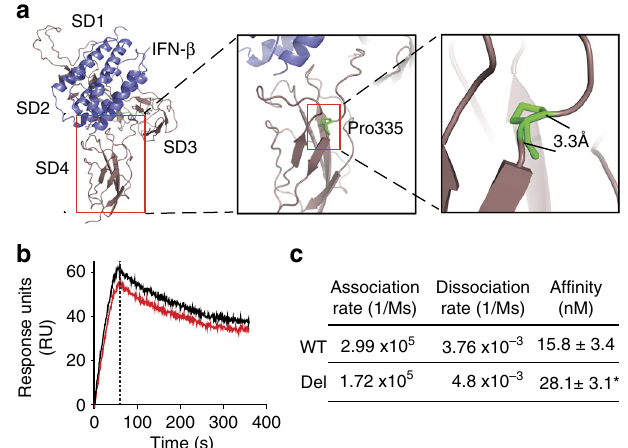
Fig. 6 TCC deletion in IFNAR1 decreases the af fi nity of IFN- β for IFNAR1. a Model of human IFNAR1 (brown; SD1 – 4) in complex with IFN- β (blue) and the location of Pro335 deletion. The model was generated using the crystal structure of the homologous mouse IFNAR1/IFN- β complex (PDB code 3WCY 53 ), illustrating overall receptor structure and position of the identi fi ed deleted residue (P335; green) in the inter-domain hinge between SD3 and SD4 of human IFNAR1. b , c The effect of TCC deletion on the IFNAR1 and IFN- β interaction. The af fi nity of human IFN- β for recombinant forms of WT IFNAR1-ECD (black) or IFNAR1-ECD-Del (red) was measured using SPR. b Sensorgram showing the kinetics of cytokine – cytokine receptor interaction. The mean response units (RU) measured over the course of triplicate experiments are shown over time. The vertical dotted line in the sensorgram represents the transition from the association phase (the “ on ” phase from 0 – 60 s) to the dissociation phase (the “ off ” phase from 61 s to the end). c Summary data showing the mean response units ± S.D. of three independent experiments. * p < 0.05 (Students t